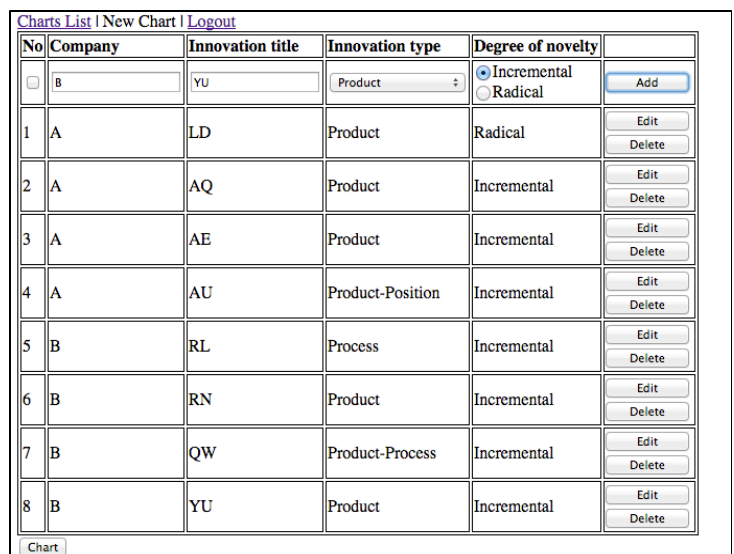
Fig. 9 . Illustration of Innovations’ List of the Model 5. Click “Chart” to map innovation.